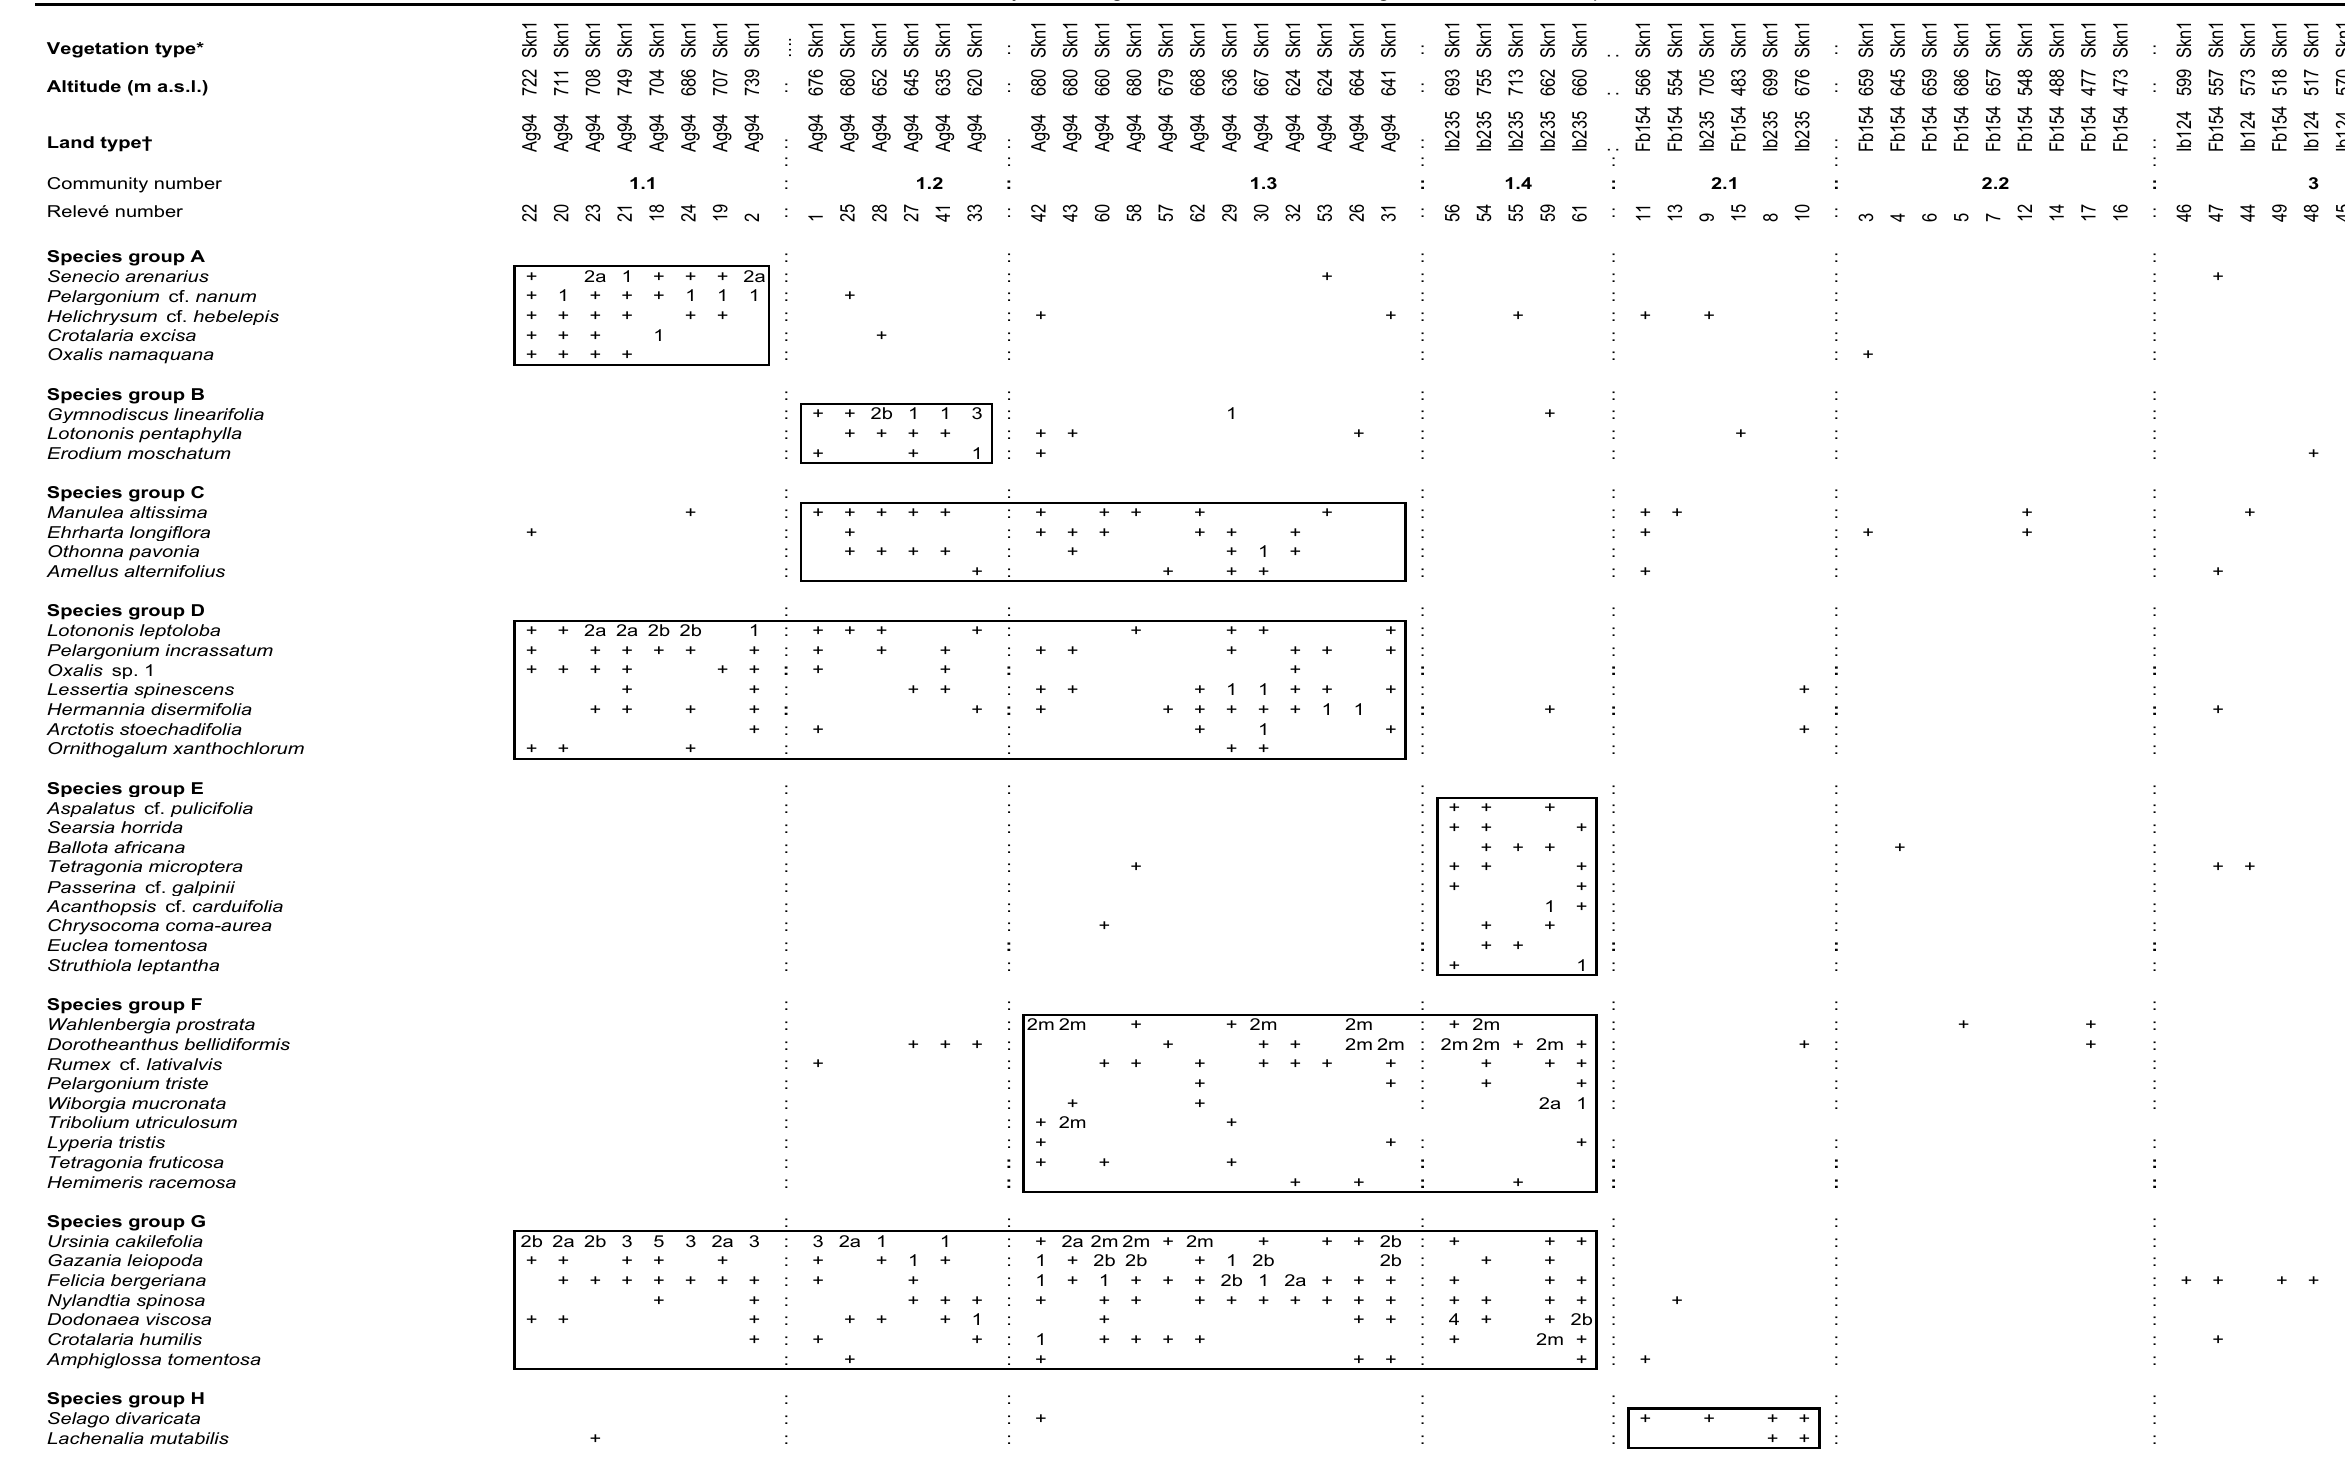
Table 1 Phytosociologial table of the old field vegetation in the Namaqua National Park Vegetation type*